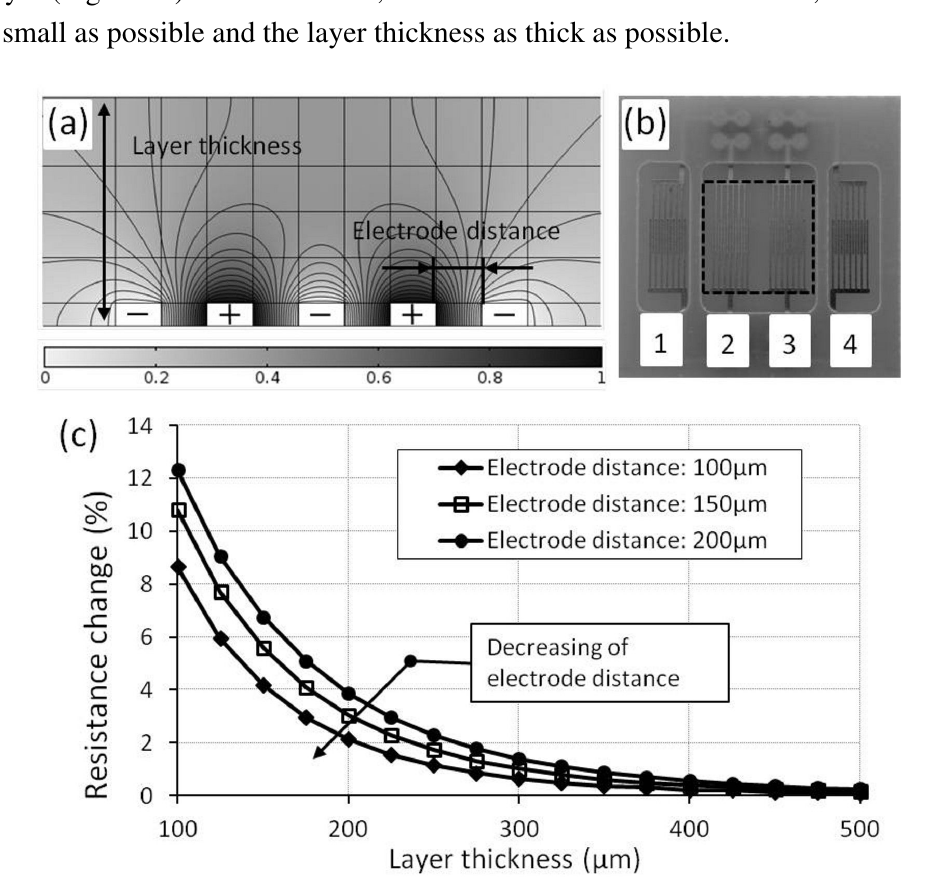
Figure 4. Electrode modeling and design: ( a ) electrical field distribution between interdigital electrodes; ( b ) image of fabricated interdigital electrodes on printed circuit board substrate; ( c ) resistance change depends on the layer thickness and electrode